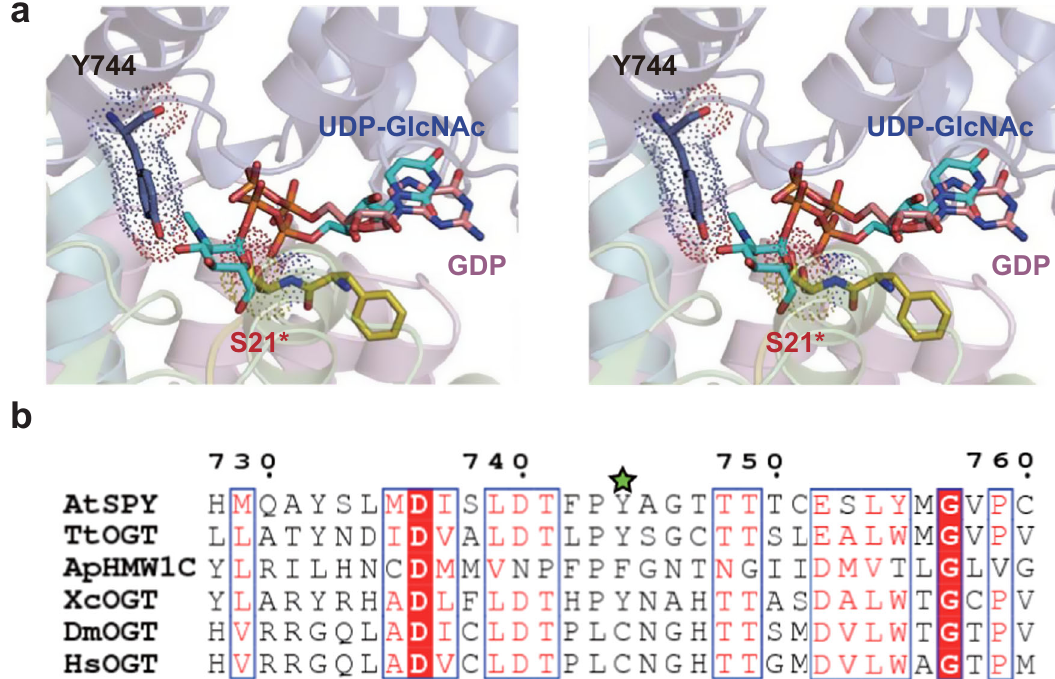
Fig.5|ComparisonofAtSPYandotherGT41proteins.a Structuralsuperposition of the active sites in the Arabidopsis ‘ catalytic SPY ’ /GDP/ ‘ substrate SPY ’ complex and the human OGT/UDP-GlcNAc/HCF-1 1 – 26 complex (PDB code 4N3C) was per- formed using the catalytic domains as a reference. For Arabidopsis ‘ catalytic SPY ’ / GDP/ ‘ substrate SPY ’ complex, GDP and some residues discussed in the text are shown as sticks. Specially, Y744 and S21* are also shown in dot representation. For simplicity, for the human OGT/UDP-GlcNAc/HCF-1 1 – 26 complex only the UDP- GlcNAc is shown as stick and colored in cyan. The fi gure is in wall-eyed stereo.